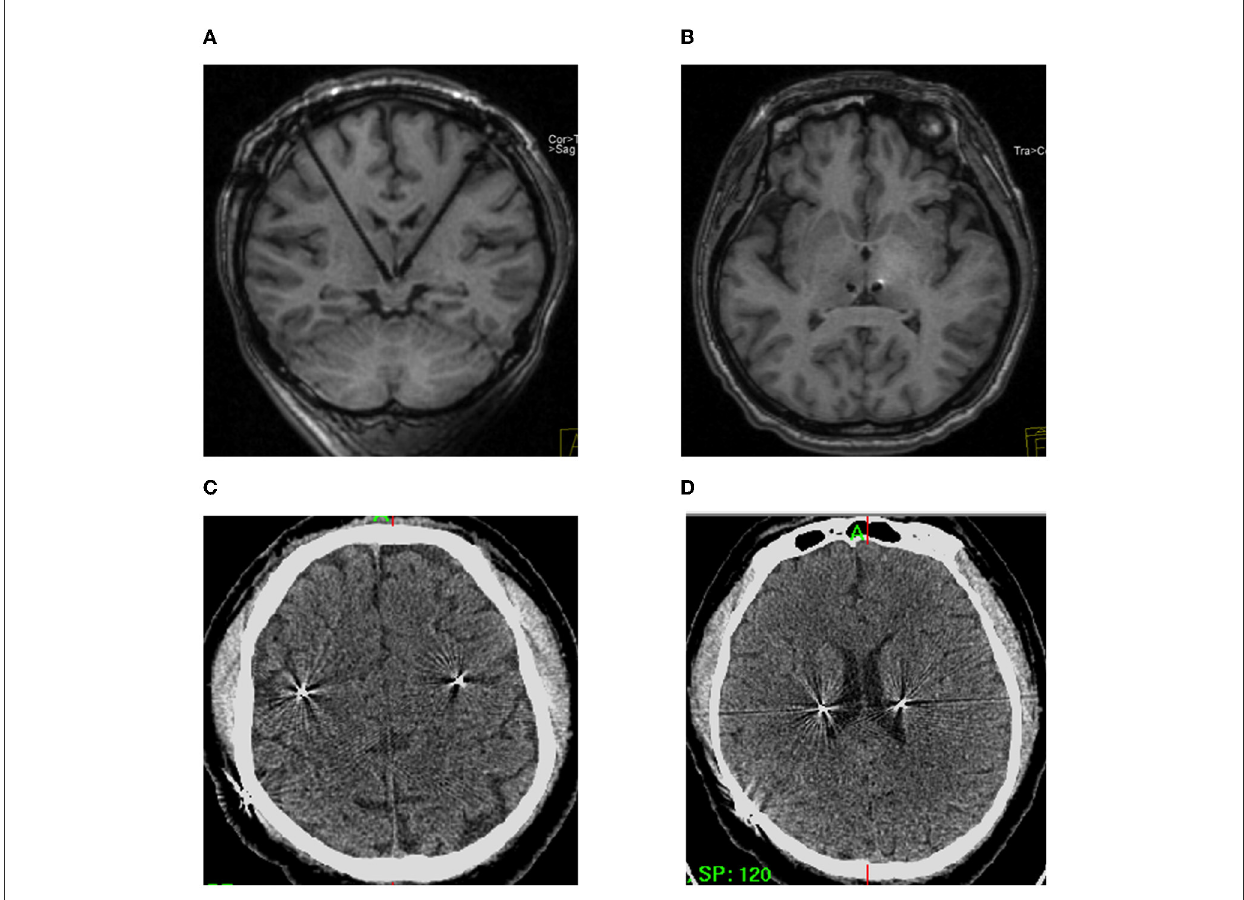
FIGURE5 Safety of the frontal trajectory of the surgical path to the LHb. (A, B) No hematoma or ischemia as confirmed by intraoperative MRI. (C, D) Post-operative CT within 72h on different planes.